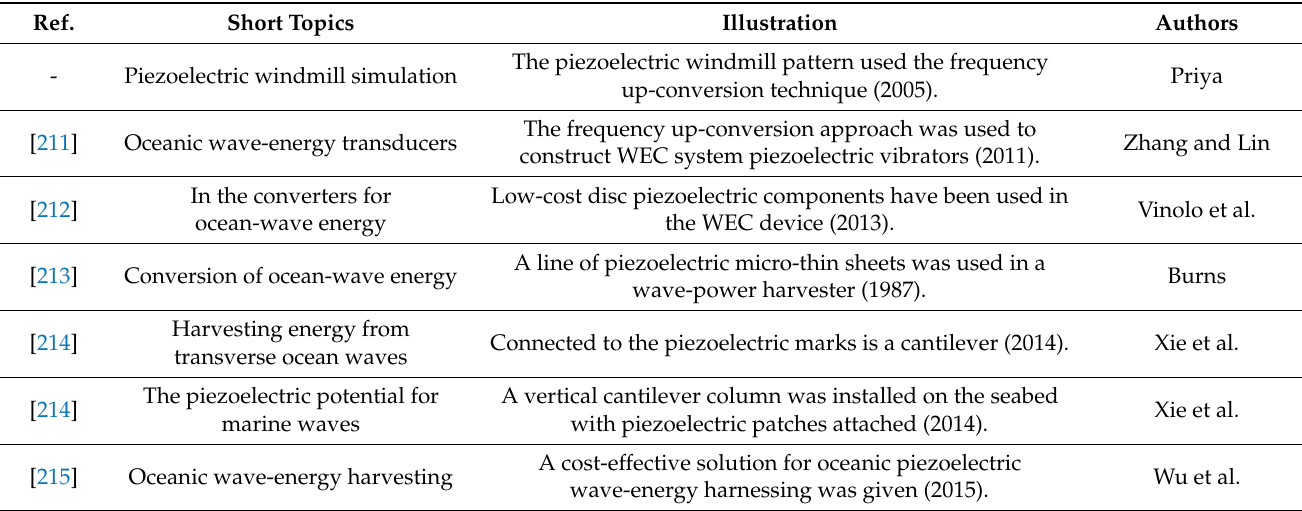
Table 6. Extractors of Piezoelectric Materials from Ocean